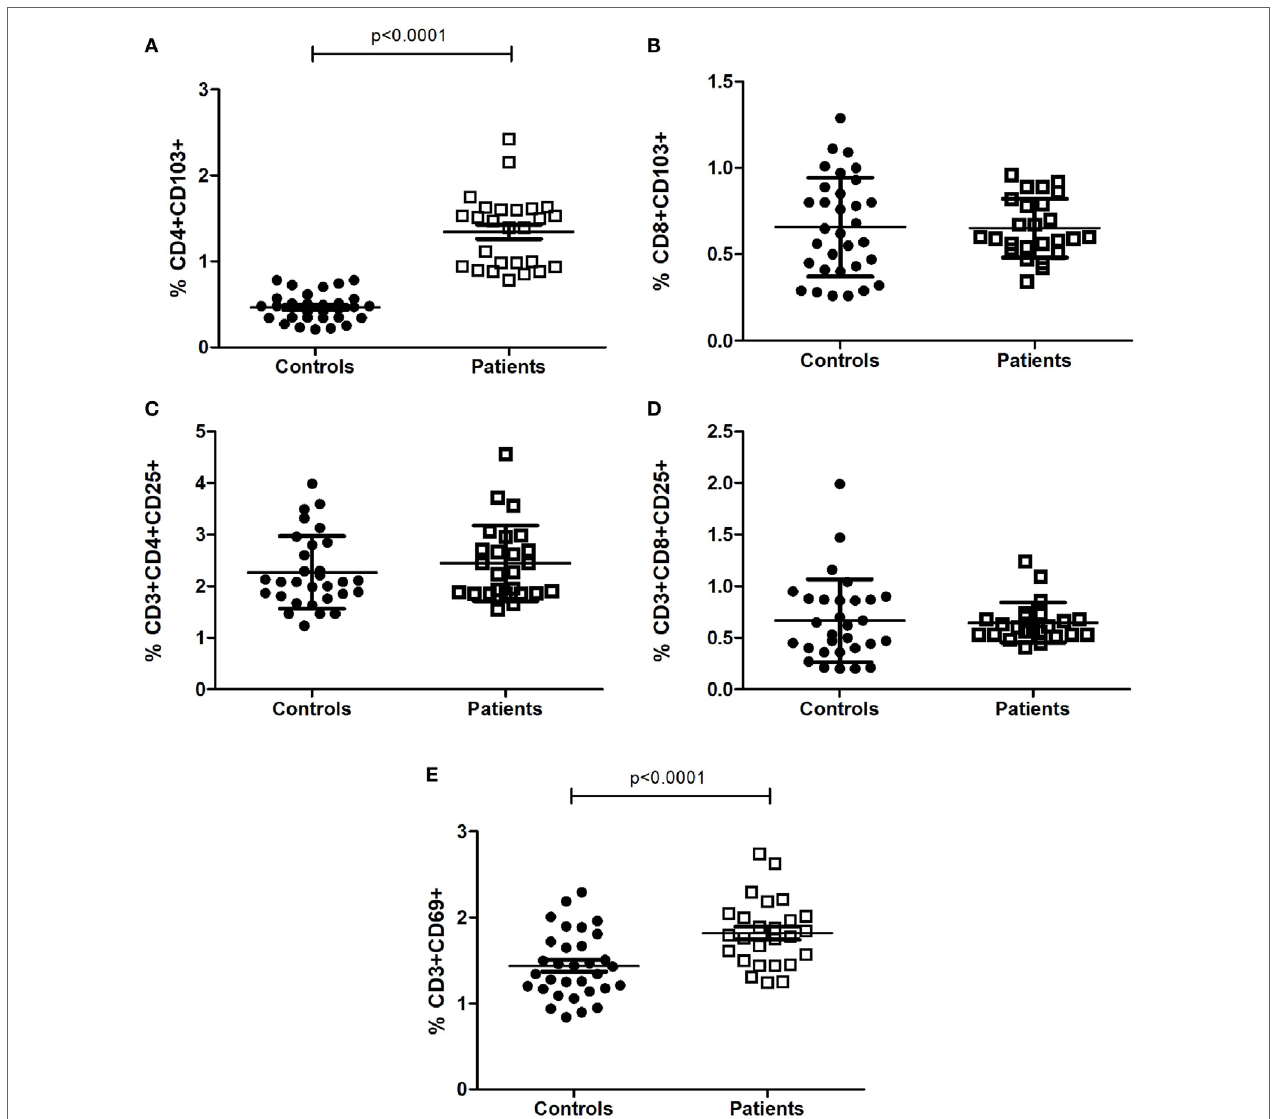
FigUre 1 | Proportion of T-cell subsets with activated (c–e) and regulatory profiles (a,B) . Statistical significant differences are indicated. Data were analyzed by Generalized Linear Modeling test (gamma or linear distribution) adjusted for age and years of